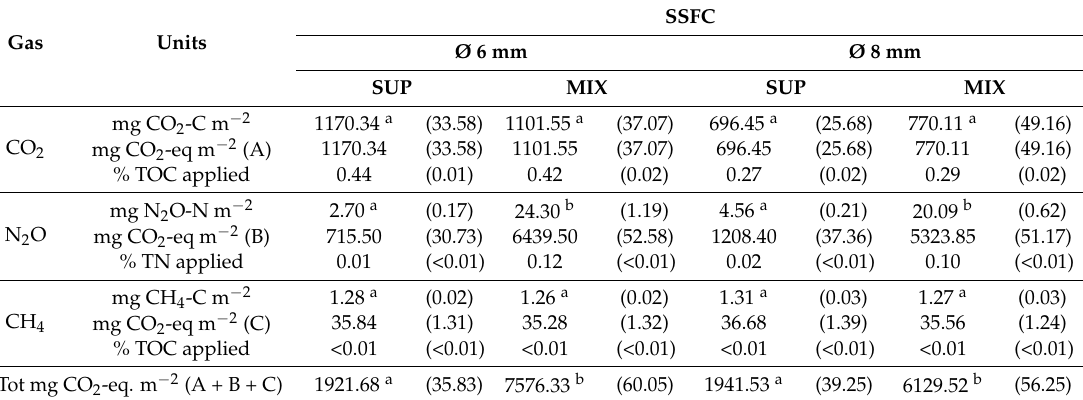
Table 3. Cumulative CO 2 , N 2 O and CH 4 emissions after 57-day experimental period related to SSFC (Slurry Solid Fraction Compost) pellet application. Mean value and standard error (in parentheses) of four replicates. Values with different letters are significantly different ( p < 0.05) within an individual experiment.